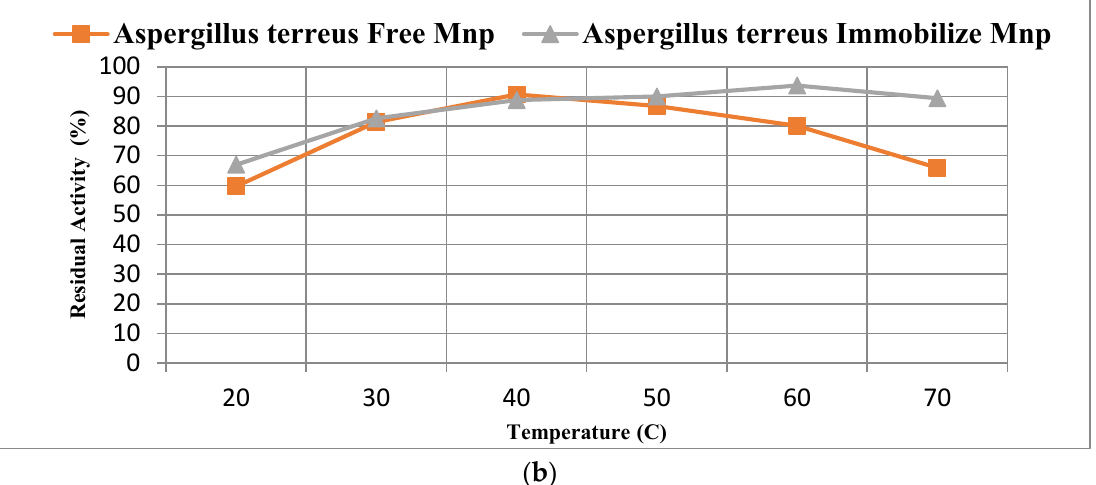
Figure 7. ( a ) The optimum temperatures for free and immobilized MnP from SN8c. ( b ) The optimum temperatures for free and immobilized MnP from SN40b.